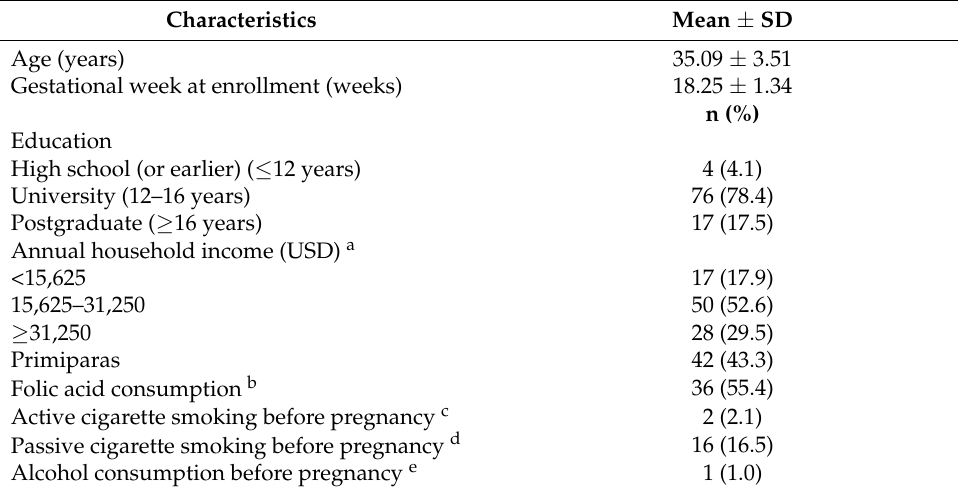
Table 1. Demographic characteristics of participated Taiwan’s pregnant women (N =